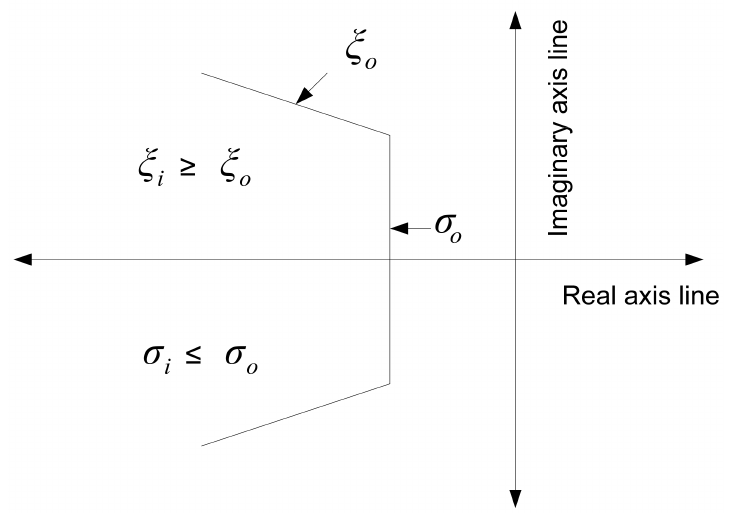
Figure 3. Eigenvalue’s locations on the